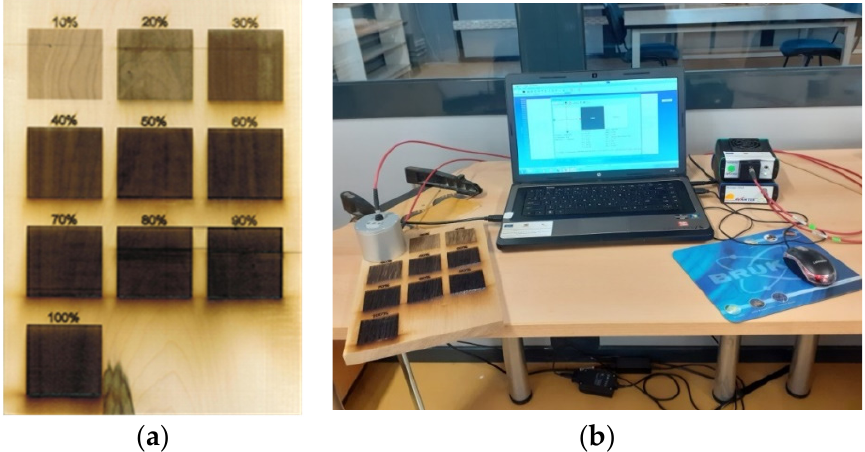
Figure 3. Sample of the preliminary study and equipment used to measure the color: ( a ) Maple wood sample; ( b ) Spectrometer AVANTES.